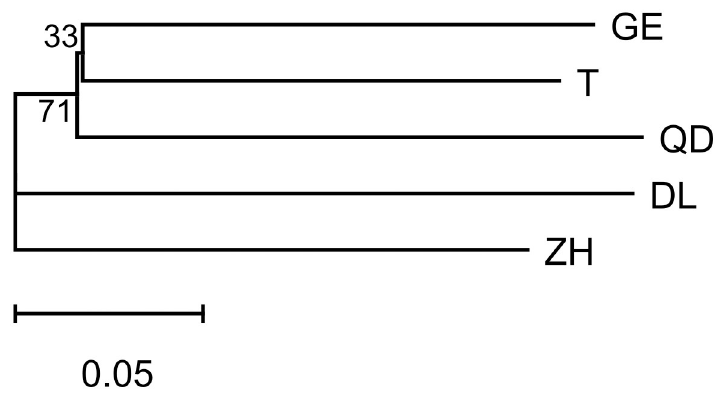
Fig 2. NJ tree based on ten microsatellite dataset from five T . japonicus populations. The scale bar at the bottom indicates the number of expected substitutions per site. Numbers by branch are bootstrap values.